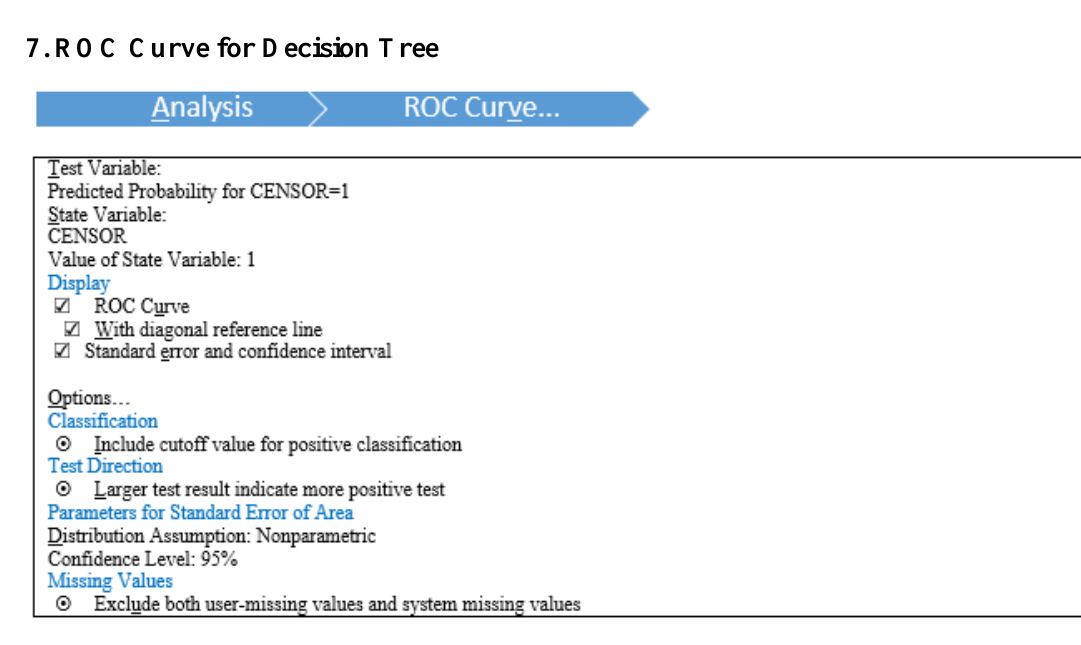
Figure 13. ROC curve for Decision Tree